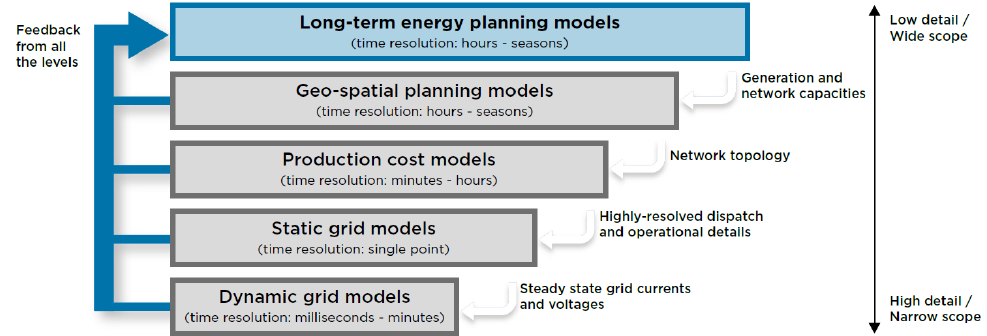
Figure 2. Analyses for energy system planning with feedback (from Figure 4 in [12])